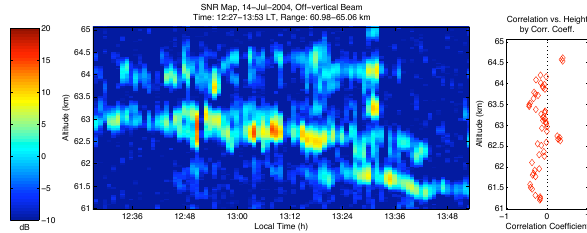
Fig. 14. A thin sheet at 64km on 14 July 2004, at 13:15 LT. R. Sheth et al.: Radar study of mesospheric fine structure Fig. 11. A thin sheet at 66.5 km on May 27 at 9:50 LT. Fig. 14. A thin sheet at 64 km on July 14, 2004, at 13:15 LT.